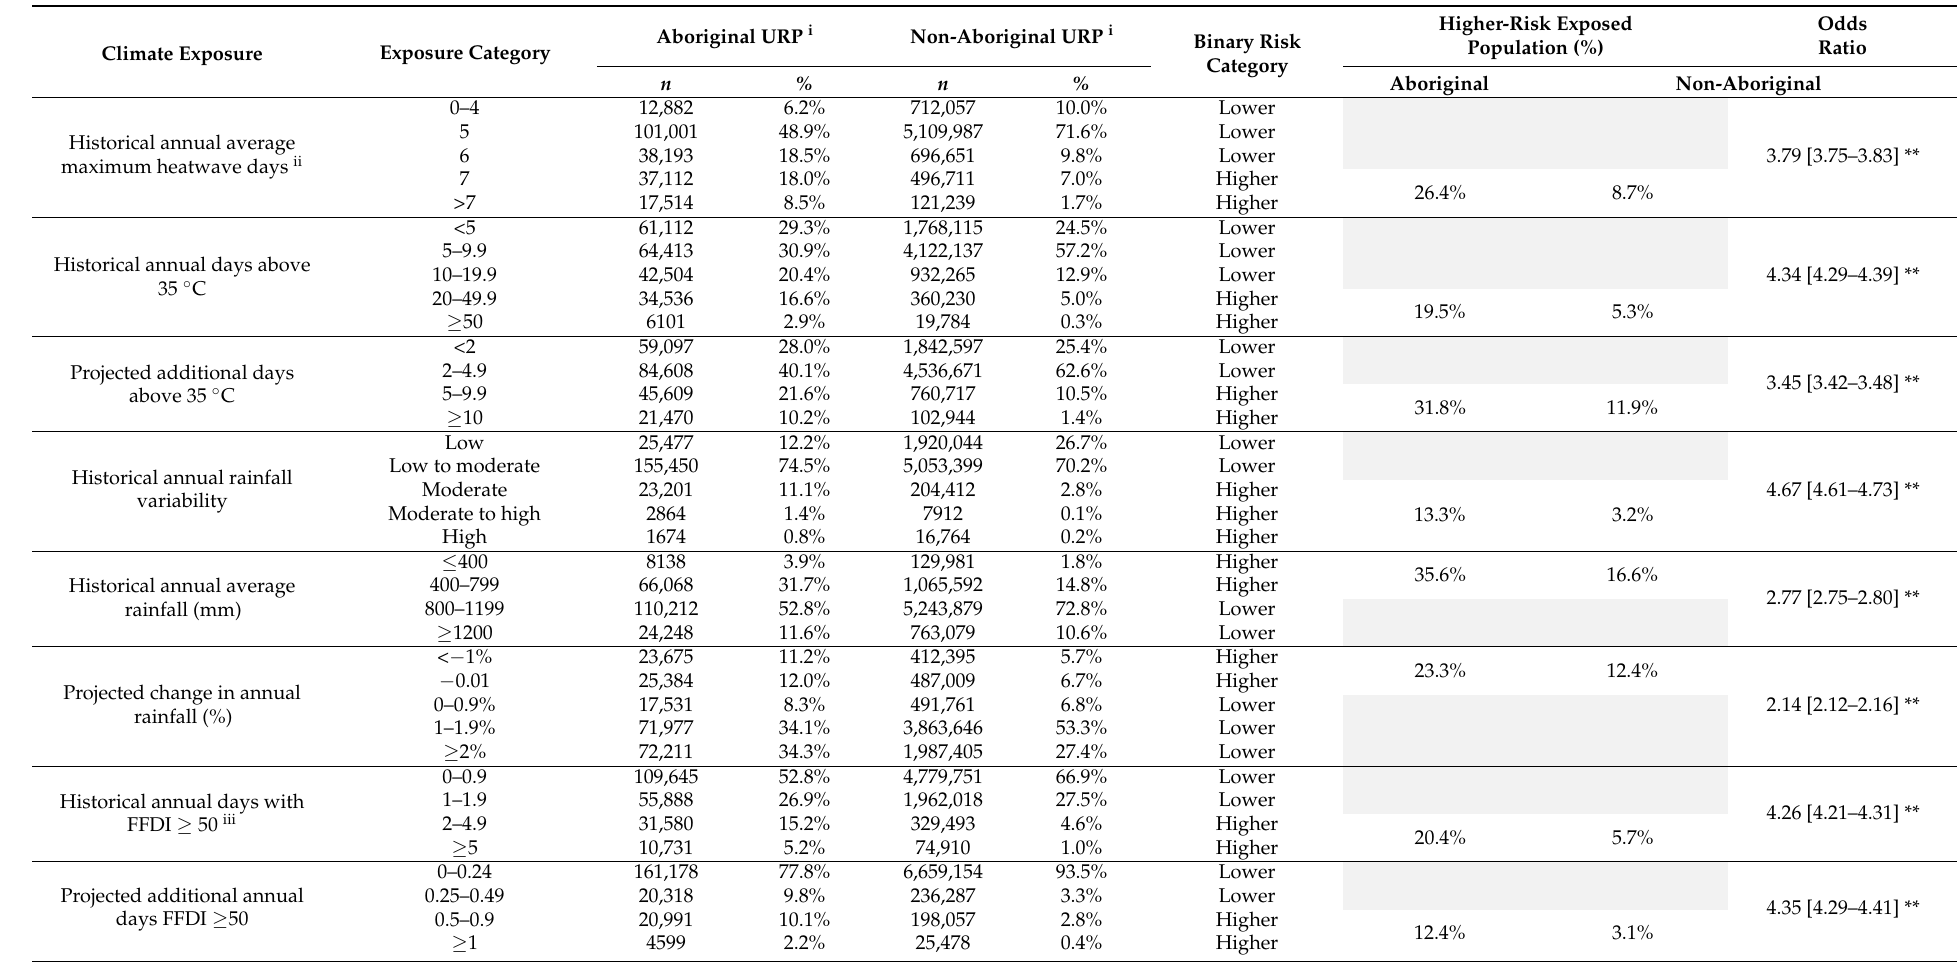
Table 1. Annual climate exposure estimates by Aboriginal versus non-Aboriginal URPs, population weighted at the Statistical Area 1 level for historical (1990–2019) and projected (2020–2039)